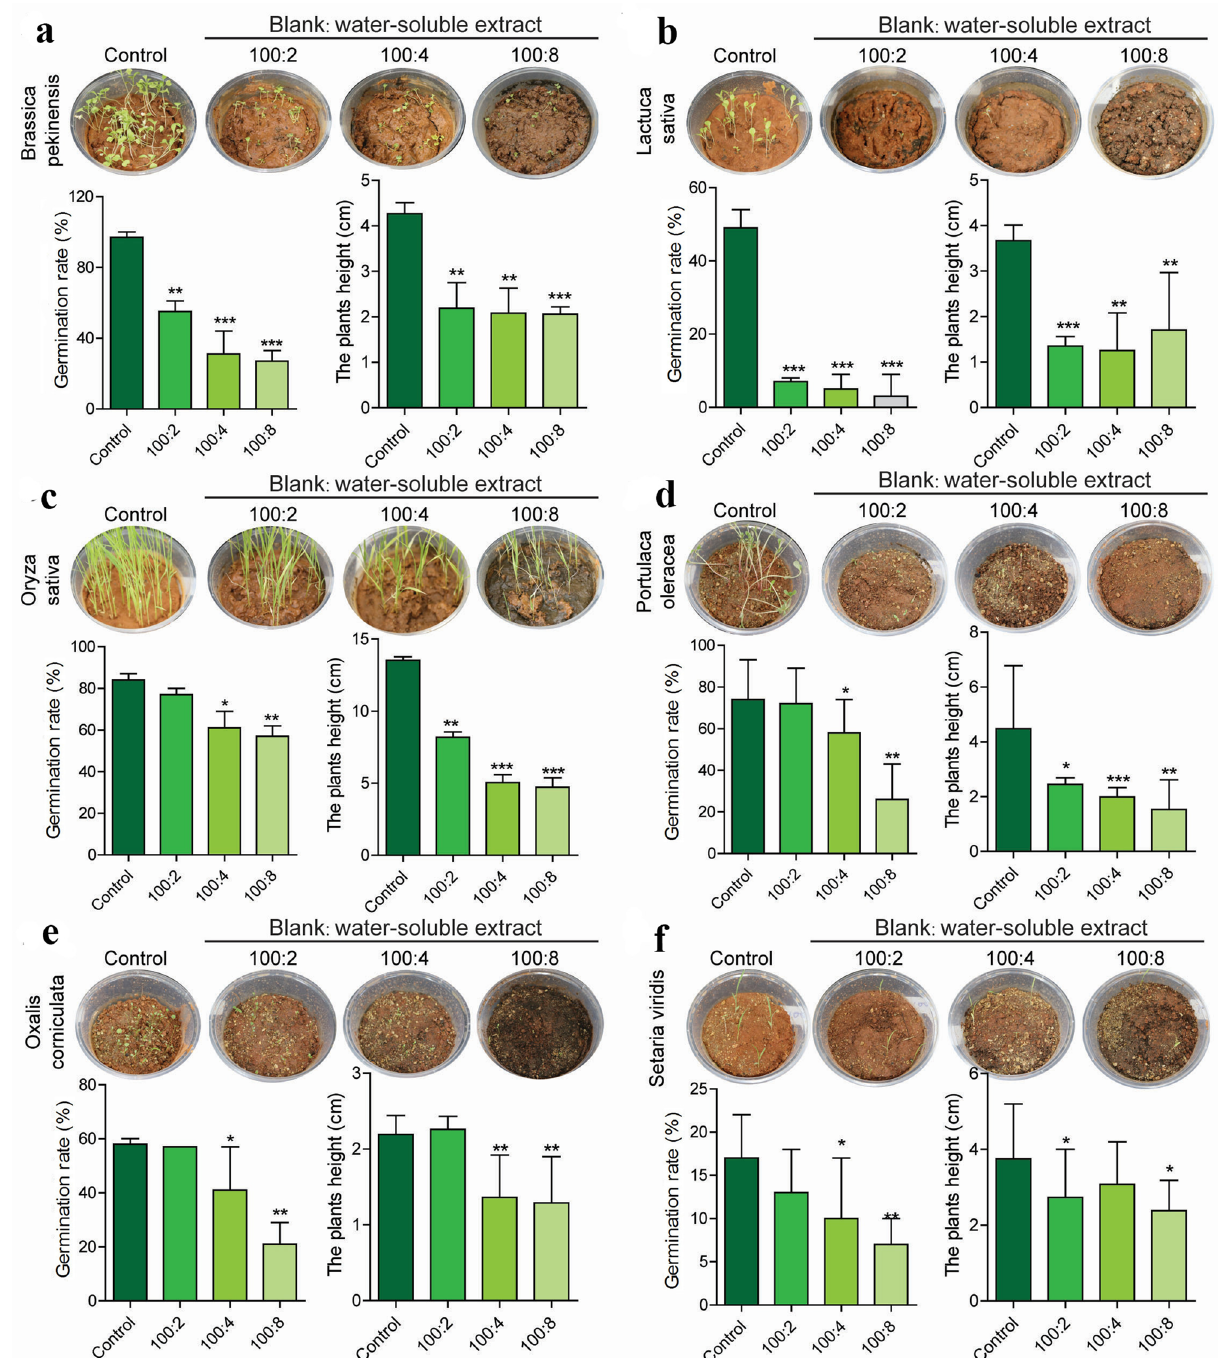
Figure 4. Mean germination index and plants height plus standard deviation for the six species with different proportions of A. argyi treatment in pot experiment: Brassica pekinensis ( a ), Lactuca sativa ( b ), Oryza sativa ( c ), Portulaca oleracea ( d ), Oxalis corniculata ( e ), Setaria viridis ( f ). (n = 3,* P < 0.05, ** P < 0.01, *** P < down-regulated genes of photosynthesis were involved in “photosystem II”, “photosystem I” and “cytochrome b6/f complex” (Fig. 7a) 16 . And the DEGs of porphyrin and chlorophyll metabolism were mainly involved in the preceding part of chlorophyll synthesis pathway (Fig. 7b) 17 . Therefore, we speculated that suppression of chlo- rophyll synthesis and photosynthesis was one of the key mechanism of A.argyi to inhibit weeds. The key genes involved in photosynthesis pathways were verified by RT-qPCR, and the results were in con- sistent with our transcriptome analysis. As shown in Fig. 8, nine genes (HEMA “encoding glutamyl-tRNA reductase”, HEML “encoding glutamate-1-semialdehyde aminotransferase”, CHLD “encoding Mg chelatase D subunit”, CHLH “encoding Mg chelatase H subunit”, CRD “encoding Mg-protoporphyrinogen IX monomethy- lester cyclase”, CHLG “encoding chlorophyll synthase”, PsbY “encoding a polyprotein of photosystem II”, PetC